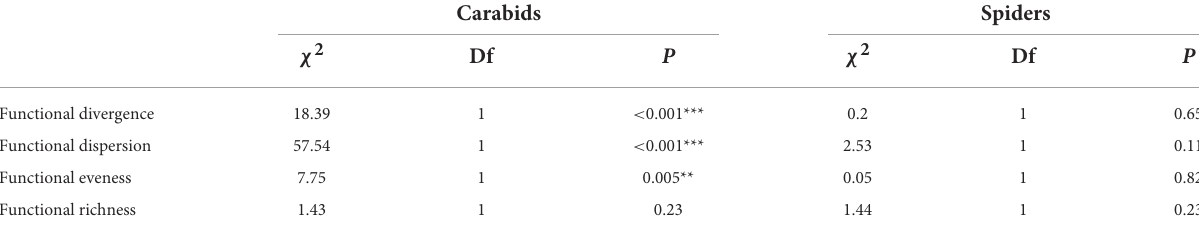
TABLE 5 Summary table of χ 2 tests applied on linear mixed models testing the impact of system type (OC and CV) on each functional diversity indicator for both carabids and